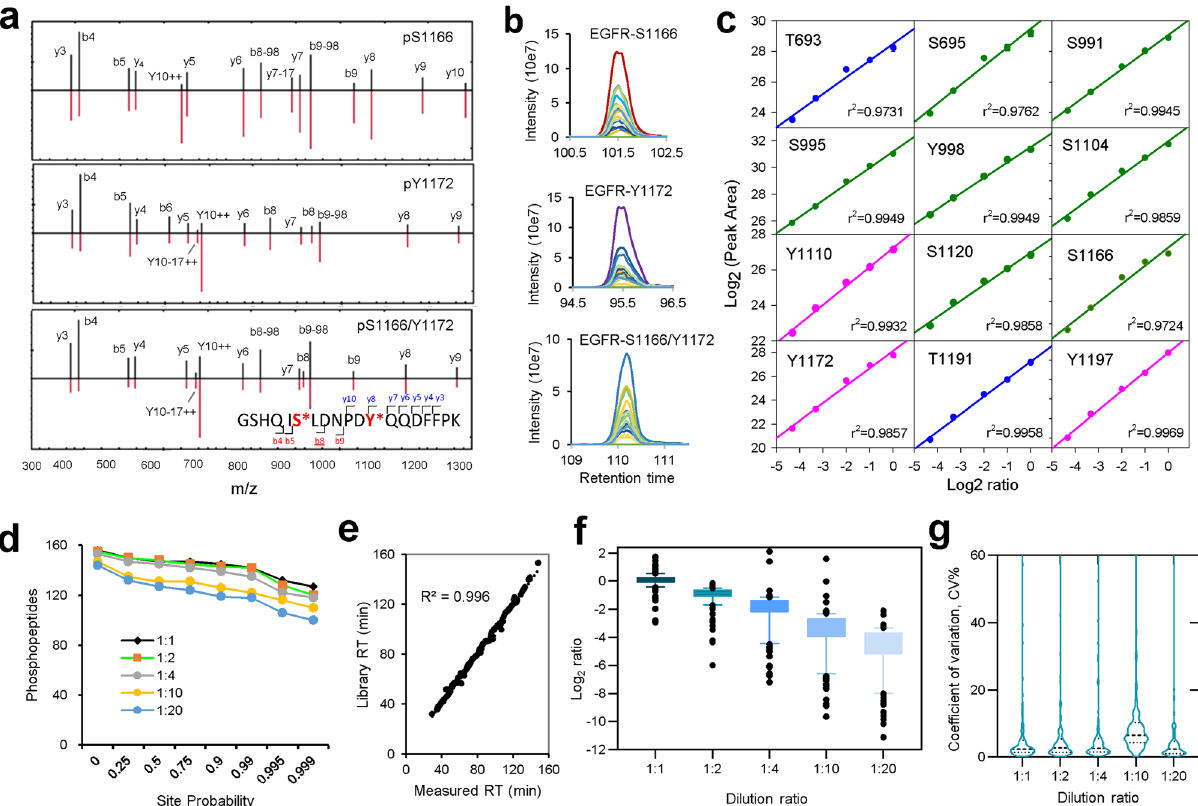
Fig. 2 Quanti fi cation performance benchmarking using synthetic phosphopeptides. Pooled samples of 166 synthetic phosphopeptides with serial dilutions (2, 1, 0.5, 0.2, and 0.1 ng) spiked into 0.5 µ g yeast tryptic peptides was used to benchmark phosphoproteome work fl ow generating spectral library. a Example DIA spectra of mono- and multiple phosphosites on the 1161 GSHQISLDNPDYQQDFFPK 1179 sequence from EGFR. Spectra matching the DIA signal (top, black line) and fragments in the library (bottom, red line) are shown. b Chromatographic elution pro fi les of the three phosphopeptides providing unambiguous detection. c Quanti fi cation linearity of 12 EGFR phosphosites across dilution series using site abundance against expected theoretical dilution ratio. d Localization probability distribution for the quanti fi ed 157 phosphopeptides in DIA scanning m / z range. Overall, among 157 phosphopeptides, 147 (93.6%), 145 (92.4%), 142 (90.4%), 131 (83.4%), and 124 (79%) were quanti fi ed as class 1 (minimum of 0.75 site-localization probability) in 1:1, 1:2, 1:4, 1:10, and 1:20 dilutions, respectively. e Correlation between measured retention time in DIA and expected time from library. f Quanti fi cation accuracy of class 1 localized phosphosites across dilution series. Box and whiskers were drawn with 10 – 90% percentile from n = 3 measurements. Median ratio of 0.95, 1.79, 3.36, 8.7, and 20.06 were observed for the theoretical ratio of 1-, 2-, 4-, 10-, and 20-fold, respectively. g Violin plot of distribution of coef fi cient of variation (CV %) of class 1 quanti fi ed phosphosites where the quartiles were shown using dot lines. A median CV% of 2.40%, 2.78%, 2.70%, 6.59%, and 2.46% were observed for phosphosites across 1:1, 1:2, 1:4, 1:10, and 1:20 dilution series, respectively. Source data are provided as a Source Data fi